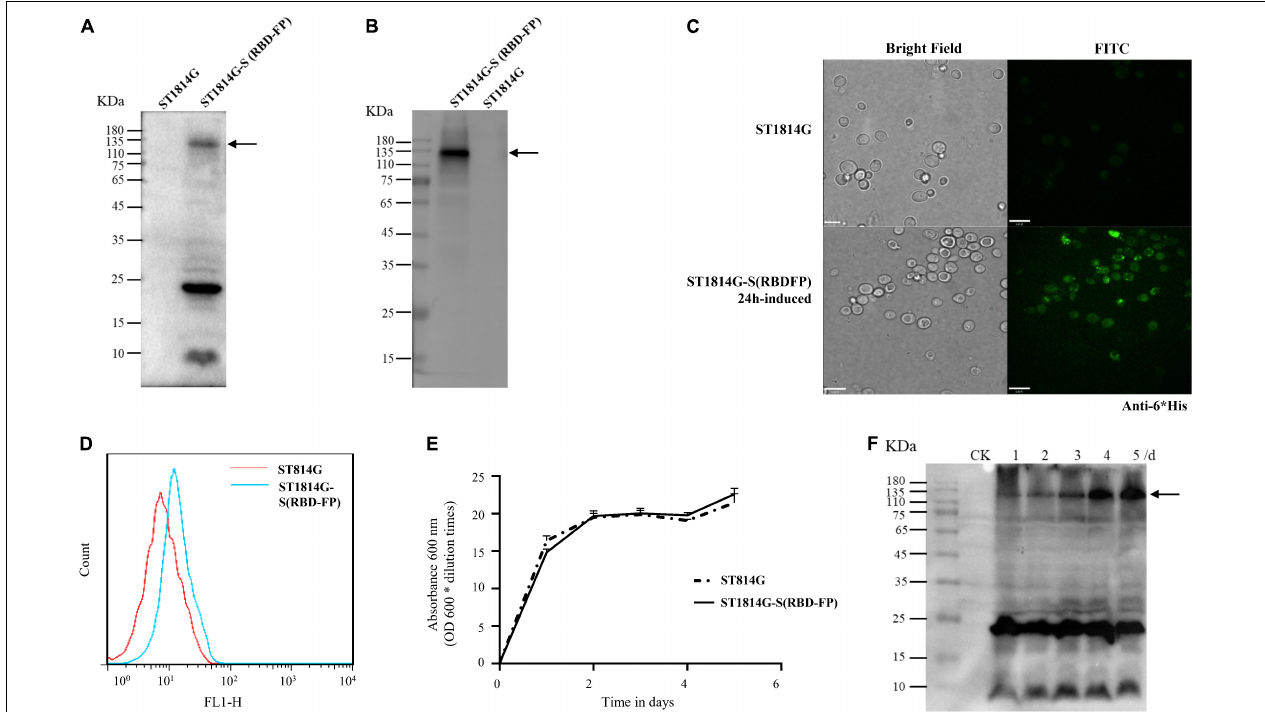
FIGURE 2 | Expression profiles of the spike S (RBD-FP) protein constructed in yeast. The expression of S (RBD-FP) was detected by Western blot with anti-His primary antibody (A) , or anti-Spike protein S1-specific antibody (B) , immunofluorescence assay (C) , and flow cytometry (D) . The fermentation kinetics was represented by recombinant yeast concentration measured by spectrophotometric method at the cultivation time points of 1, 2, 3, 4, and 5 days (E) . Spike protein expression at each time point was detected by Western blot (F)